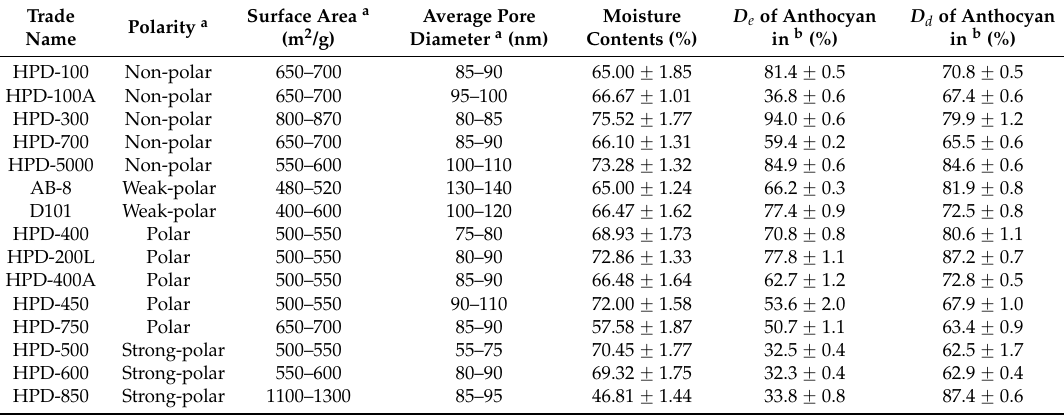
a Parameters in the table provided by manufacturer of the resins . b In the static absorption and desorption experiment, 1.0 g adsorbent (dry resin weight) together with 50 mL of extract solution were added into a flask, shaken (100 rpm) for 8 h at 25 °C. After adsorption, the resins were washed with 50 mL deionized repeated three times.